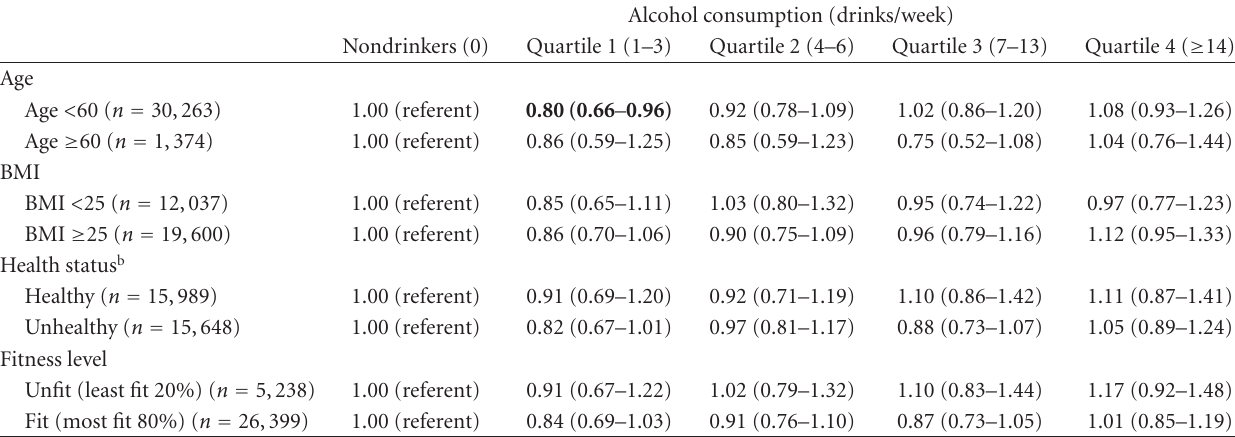
Table 4: Hazard ratios of all-cause mortality stratified by risk factors a , Aerobics Center for Longitudinal Study (ACLS),